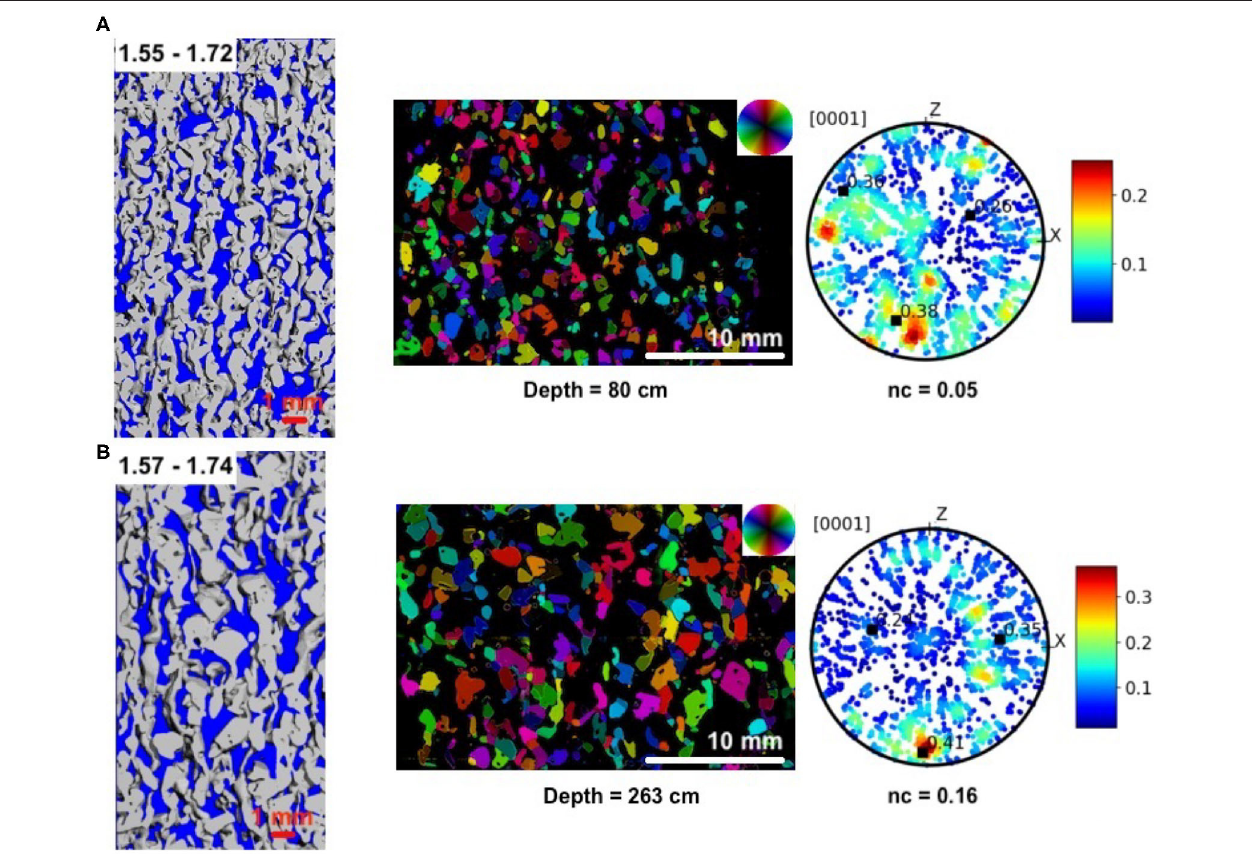
FIGURE 4 | MicroCT structure, microstructure and c -axis pole figure from samples extracted at 80 (A) and 263 (B) cm depth along the EastGRIP snow pit. The thin section was made in the microCT sample. A range of ǫ values is given in the microCT structure. The figures of microstructure are color-coded with the colorwheel that represents orientations of the c-axis. On the pole figures, 5,000 pixels are plotted. The black squares correspond to the location of the eigenvectors of a (2) , and the associated eigenvalues are given. nc is the cluster index. The z-axis is the same for the three